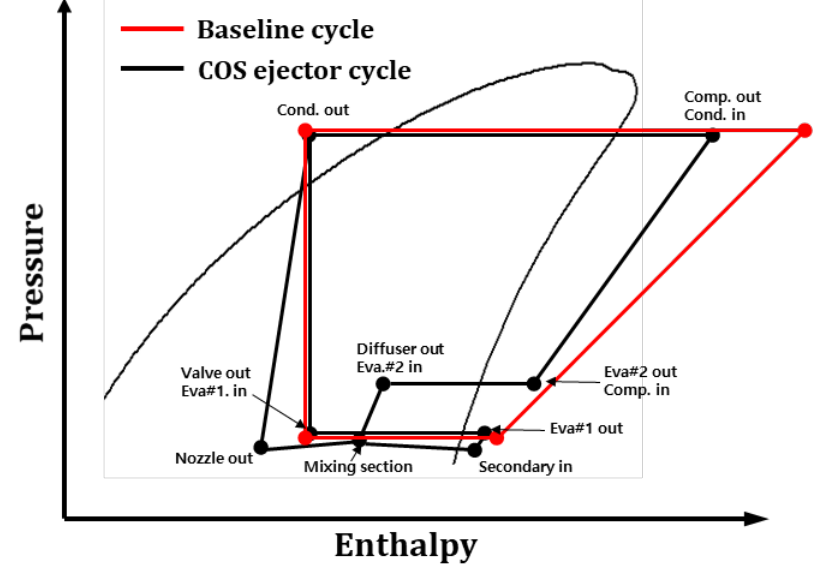
Figure 1. Pressure–enthalpy diagrams of the baseline cycle and the condenser outlet split (COS) ejector cycle.